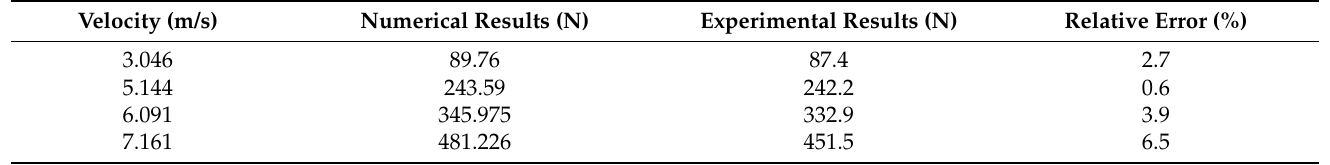
Table 2. Relative errors between the numerical results and the experimental results.